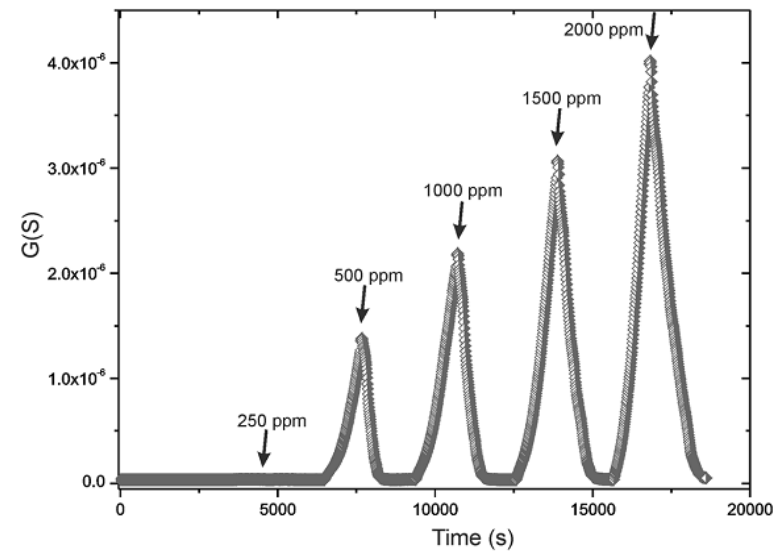
Figure 8. 5% SnO 2 -CeO sensor response/recovery characteristics at T w = 400 °C, from ref. [40].